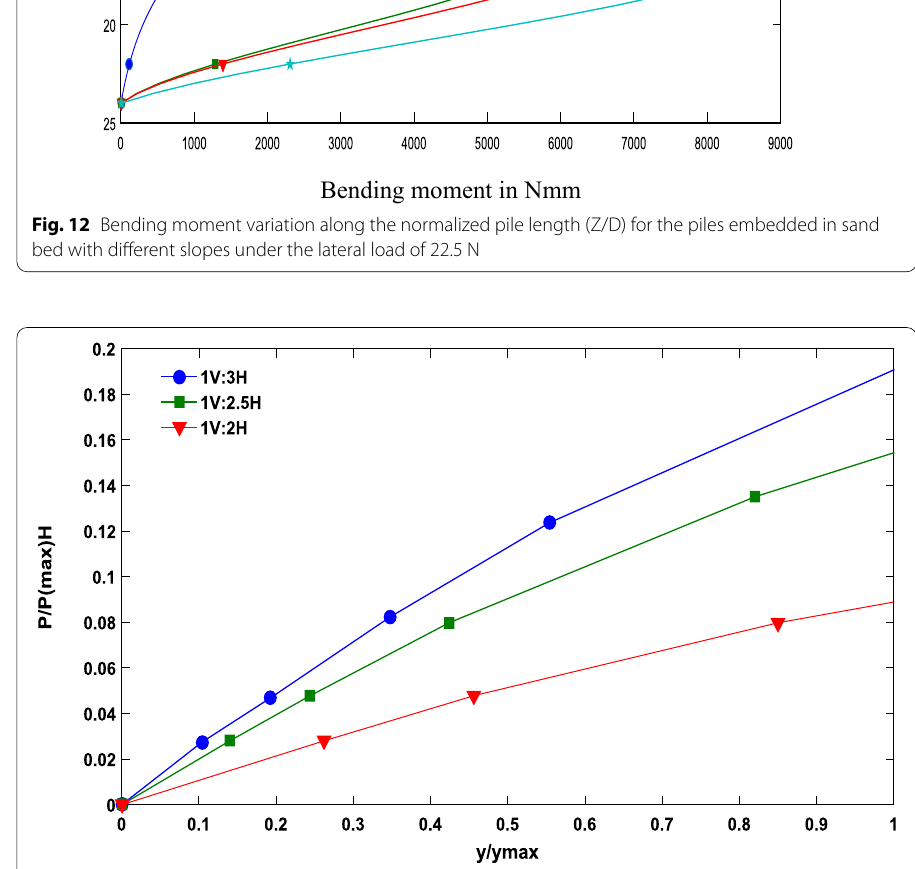
Fig. 13 Lateral load carrying capacity of pile between different slopes under forward